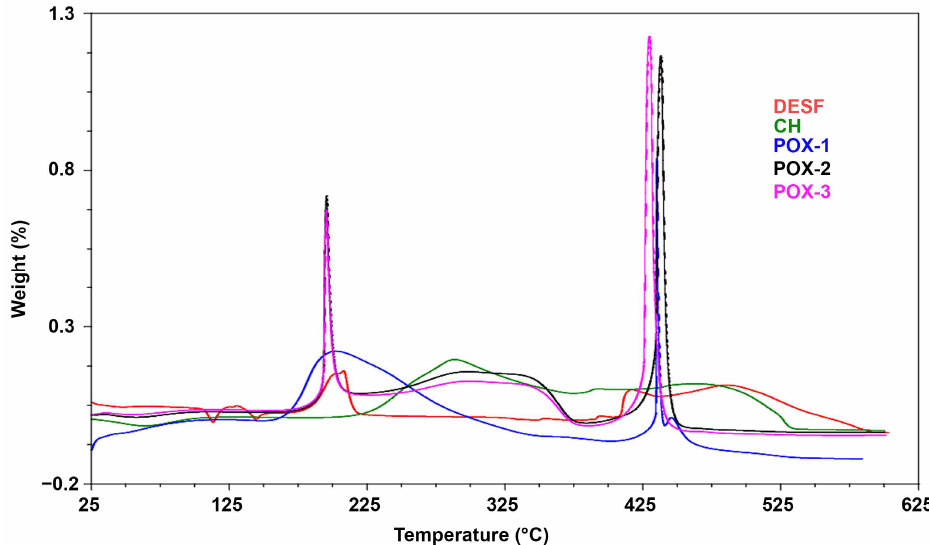
Figure 5. DTA curves of DESF, CH, POX-1, POX-2, POX-3.